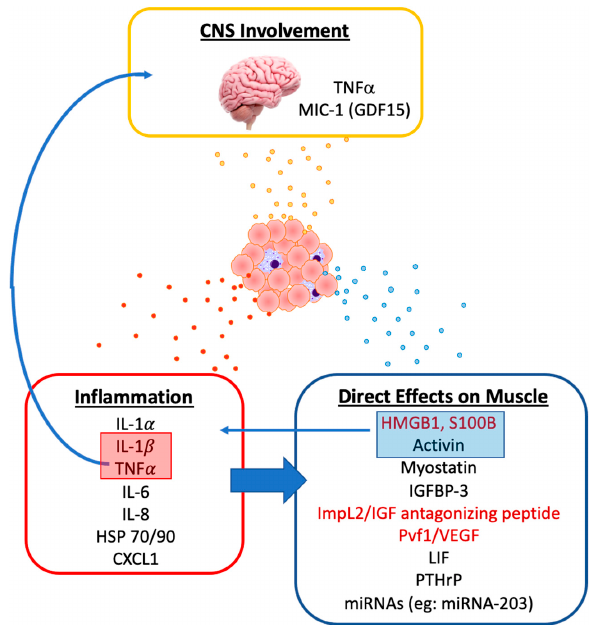
Figure 2. Tumor-derived factors have been described that are pro-inflammatory in nature, target the central nervous system (CNS) and directly target muscle. Mediators in red are also known to encourage tumor